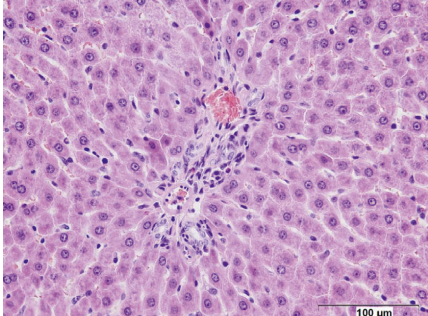
Figure 5: Inflammatory infiltrate inside the kidney interstitium (HE, x400).